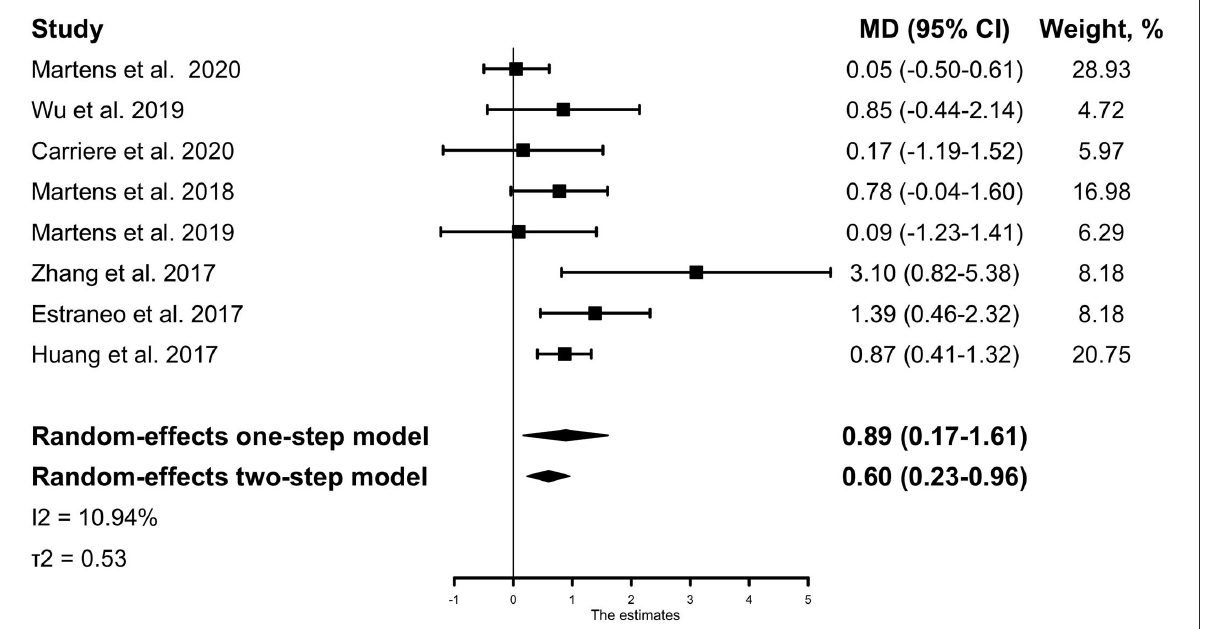
FIGURE2 The IPD meta-analysis for all included studies: mean CRS-R score change between pre- and post-tDCS for the treatment group vs. the control group. The Forest plot shows the positive MD both in the one-stage and two-stage meta-analysis method, meaning that active tDCS can significantly improve patients’ CRS-R scores than sham tDCS. The mean differences were adjusted for the following variables: age, sex, baseline CRS-R score, etiology of injury, and time from injury to tDCS intervention. MD, mean difference; CRS-R, Coma Recovery